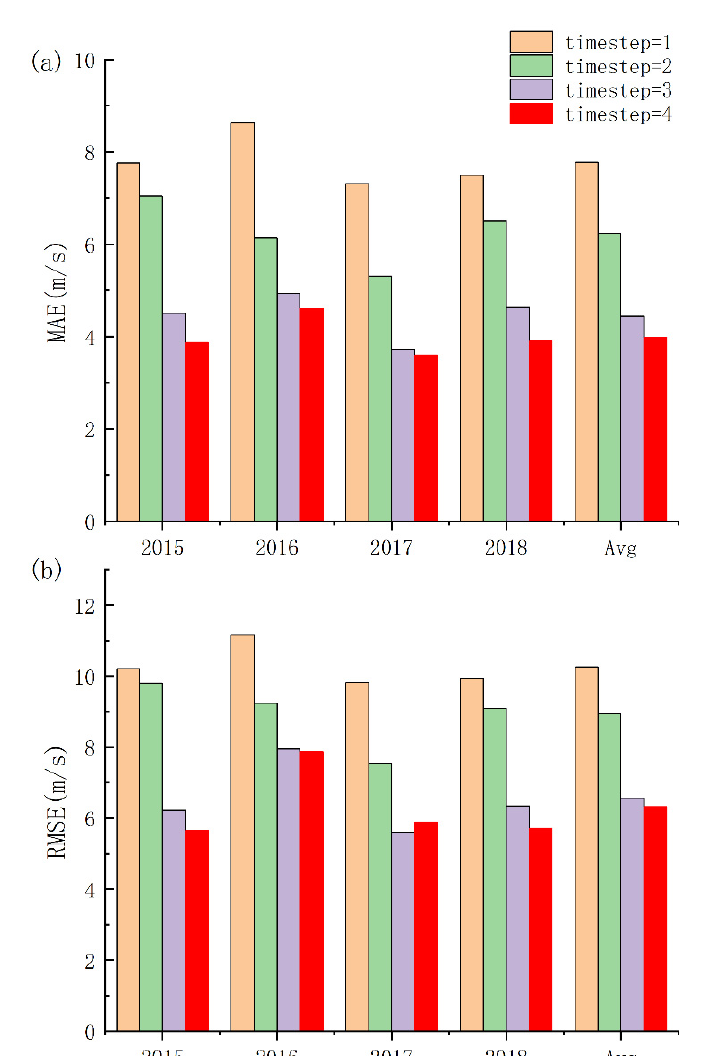
Figure 5. The experimental results of 24 h typhoon intensity forecasting with different sequence lengths based on the TITP-Net model. ( a ) Evaluation of the MAE from 2015–2018 and the four-year average error. Different colored histograms represent different input sequence lengths. The his- tograms for each sequence length in different years represent typhoon intensity forecasting results in 24h. The red bar represents the optimal sequence length with the smallest error. ( b ) Evaluation of the RMSE from 2015–2018 and the four-year average